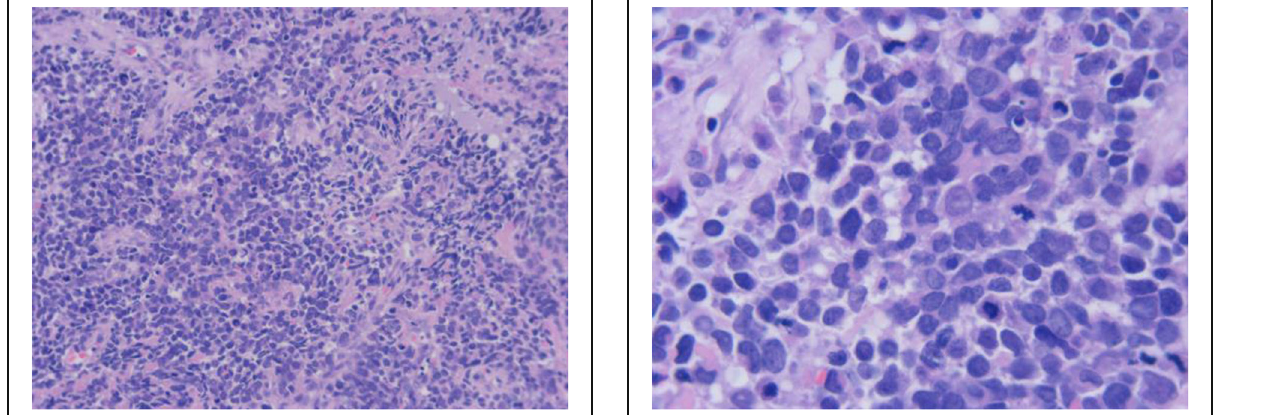
Fig. 3 Fine nuclear chromatin can be observed with small nucleoli; moreover, the tumor cells are strongly eosinophilic with large nucleoli